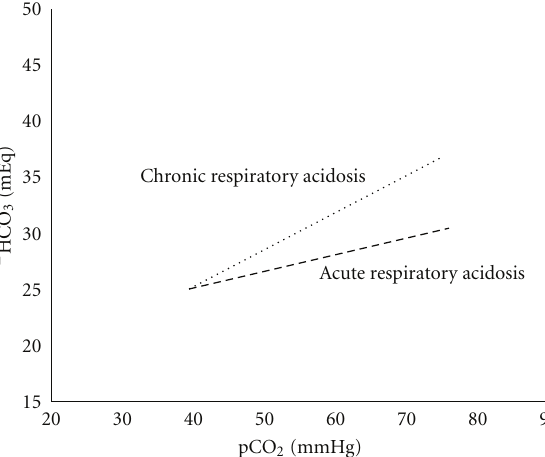
Figure 5: Relationship between pCO 2 and bicarbonate in acute and chronic respiratory